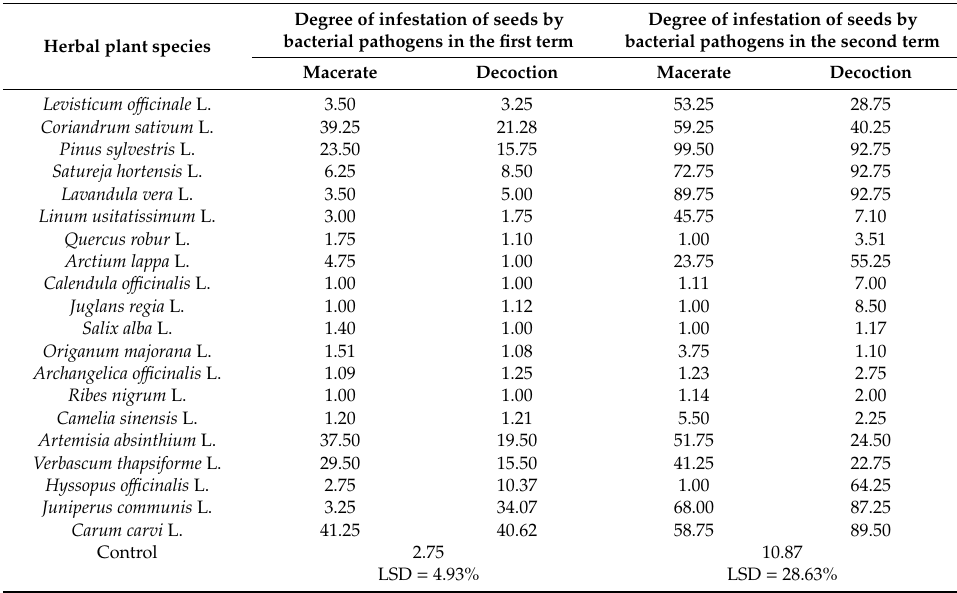
Table 6. The influence of the method of obtaining plant extracts on the degree of seed contamination by bacterial microorganisms (%). Degree of infestation of seeds by Degree of infestation of seeds by bacterial pathogens in the first term bacterial pathogens in the second term Herbal plant species Macerate Decoction Macerate Decoction Levisticum o ffi cinale